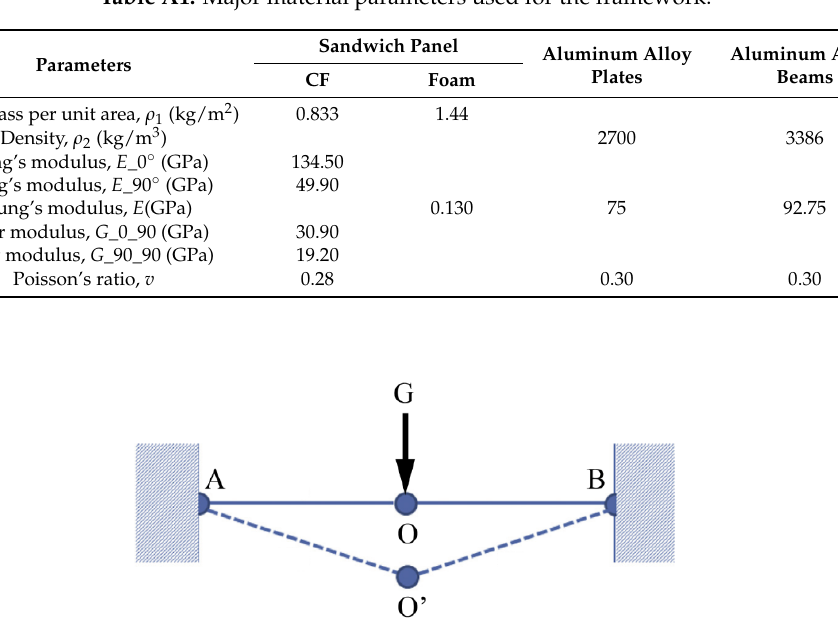
Figure A1. Schematic diagram of “curtain effect” (modified and redrawn from Reference [36]). Explanation: when the object AB (e.g., curtain or cable) is large, its center point drops from O to